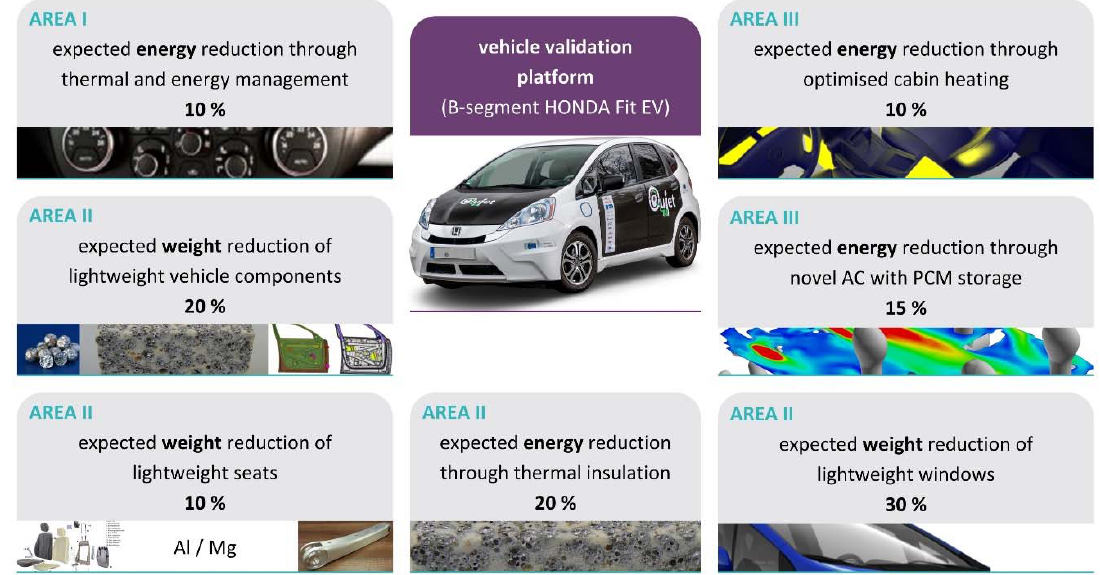
Figure 1. Expected reduction in energy consumption and weight in each of the three areas of the QUIET project [18,19]. Image © The QUIET project [23].